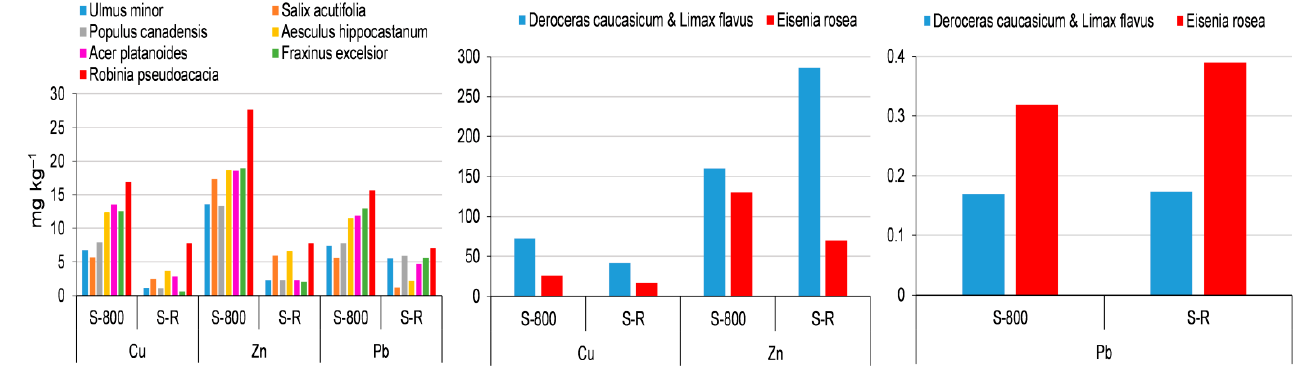
Figure 6. Concentrations of some HMs in the plant leaves and invertebrates from the areas located at different distances from the Alaverdi copper smelter.